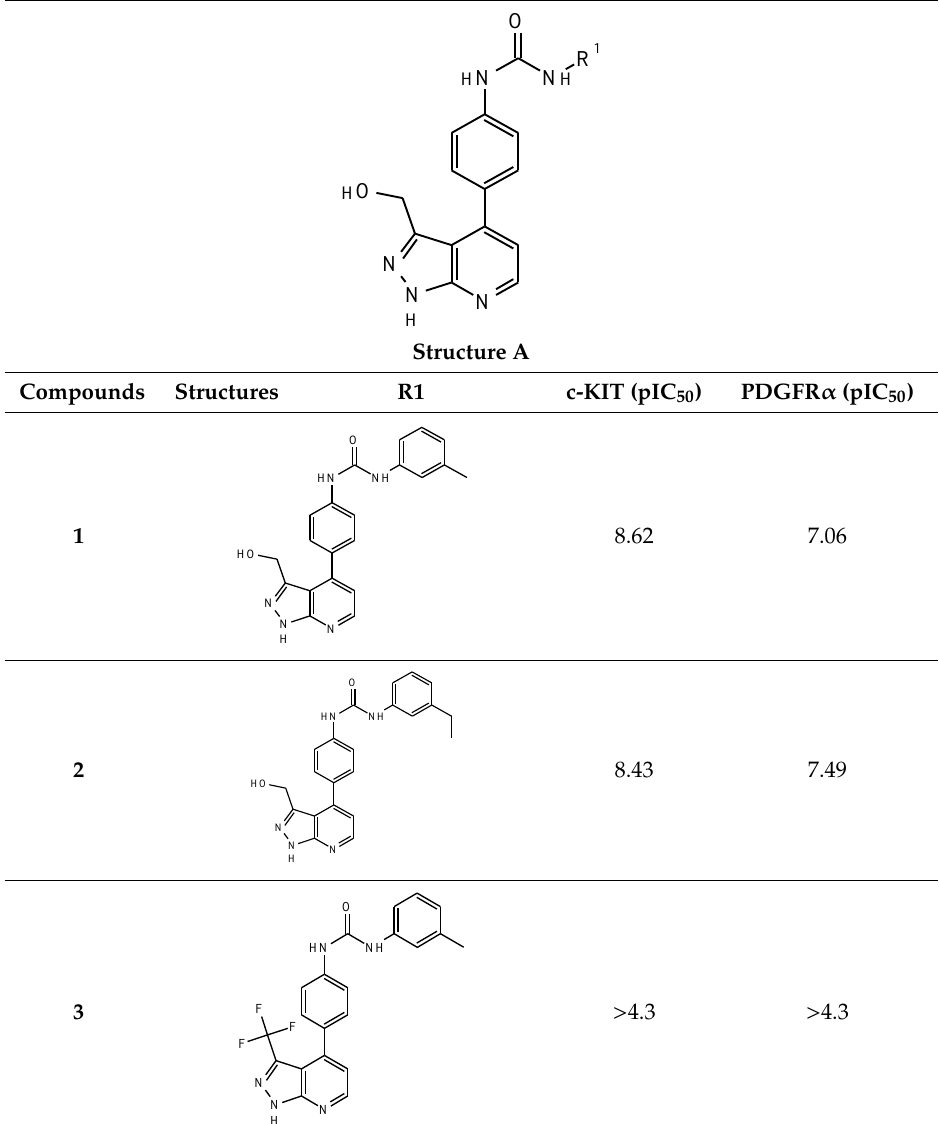
Table 1. Structure of the pyrazolopyridine derivatives and their pIC 50 values for stem cell factor receptor (c-KIT) and platelet-derived growth factor receptor alpha (PDGFRα).